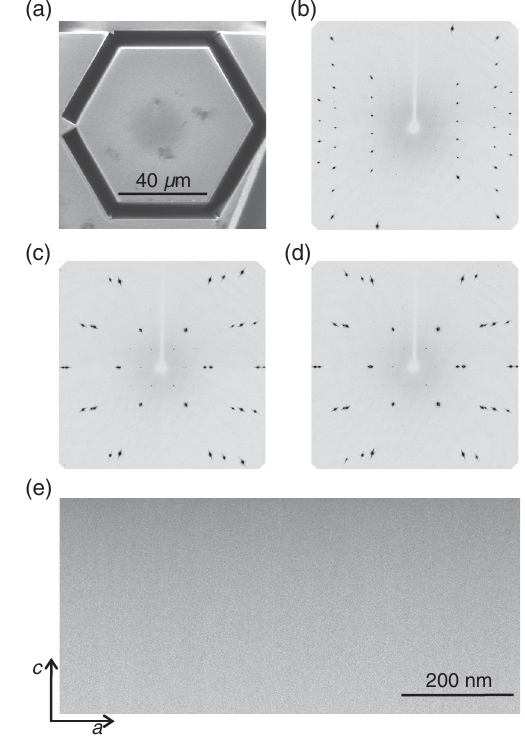
FIG. 2. SEM image of the microstructured PtCoO 2 sample used for the x-ray diffraction experiment. Subsequent to this image being taken it was removed from the background crystal and gently mounted for the experiment. The unique crystallographic axis [labelled c in Fig. 1(a)] is perpendicular to the main plane of the crystal. (b) – (d) Oscillation images taken about (b) the unique and (c),(d) the two equivalent axes of the hexagonal unit cell. Weak additional spots originate from the λ = 2 contributions for most intense Bragg reflections. (e) STEM image of PtCoO 2 taken at low magnification, resolving no defects.